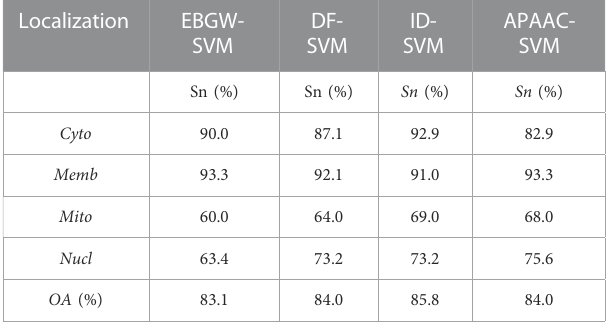
TABLE 3 Comparison of prediction performance for different methods on the ZW225